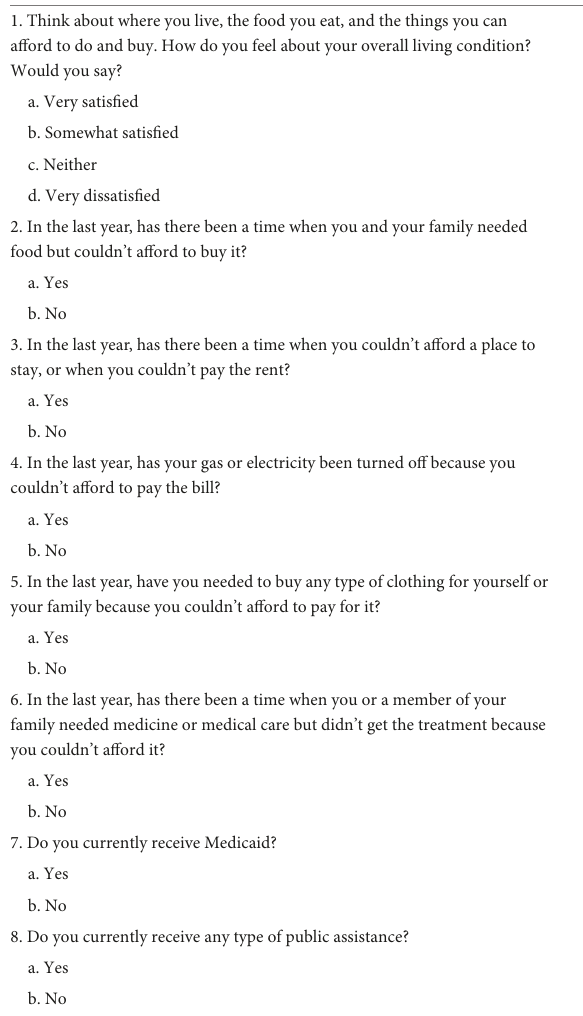
TABLE 1 Survey questions examining material